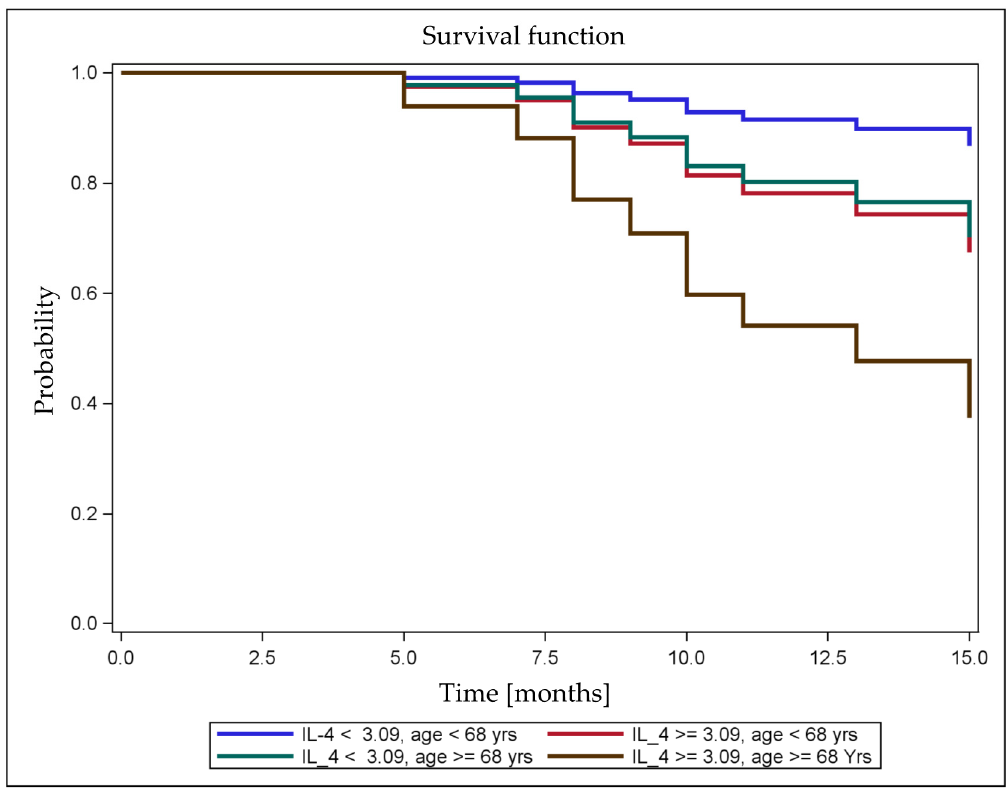
Figure 5. Postoperative survival curves predicted using the Cox model. Postoperative RFS after curative-intent surgery for NSCLC was predicted based on the variables serum IL-4 levels and age. Prolonged survival was predicted for younger patients with low serum IL-4 levels than for older patients with high serum IL-4 levels. The favorable effect of younger age on survival was reversed by the combination with higher serum IL-4 levels.